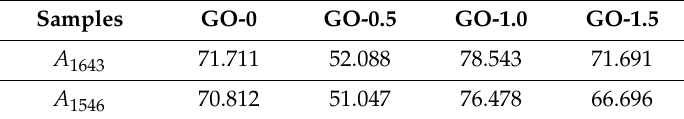
Figure 7. The FTIR spectrum of CSAs / GO aerogels. Table 4. The values of A 1643 and A 1546 for each sample.